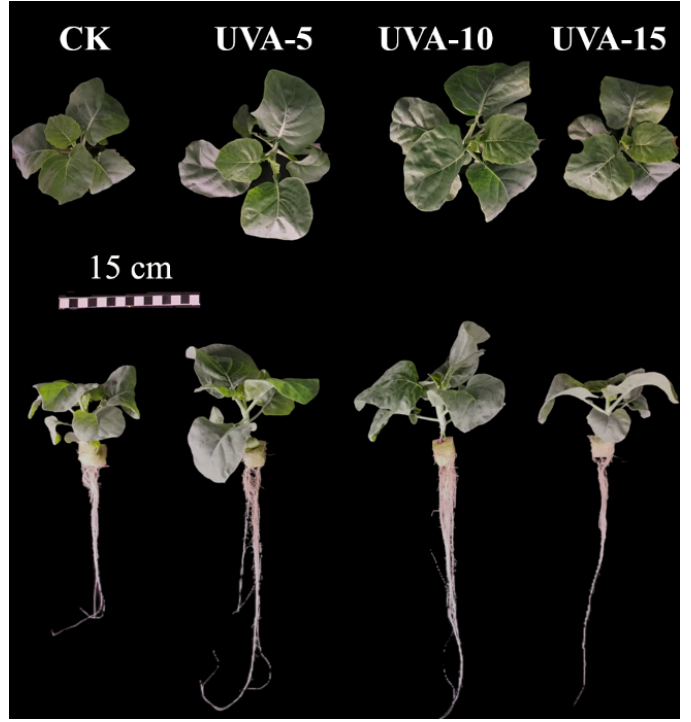
Figure 2. The Chinese kale baby-leaves morphology at 10 days after treatments. CK = control. UVA-5, UVA-10, and UVA-15 indicated UV-A intensity of 5, 10, 15 W ‧ m –2 , respectively.